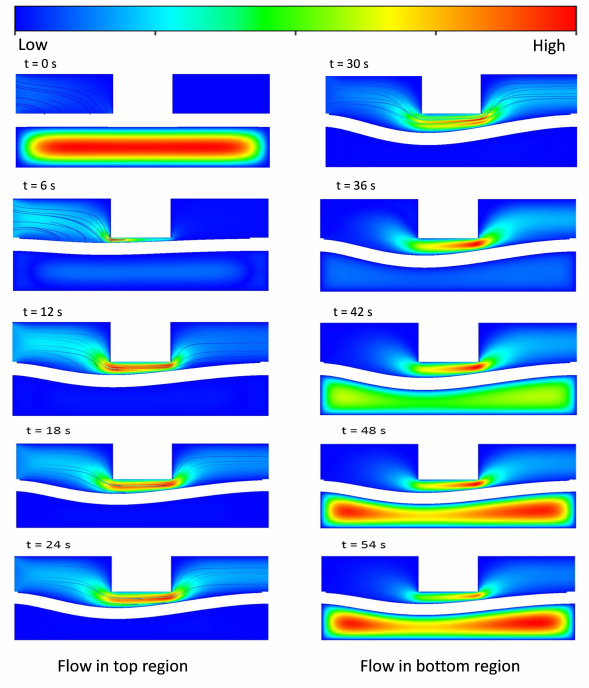
Figure 9. Velocity contours’ fields and streamlines for various time steps for L/W = 0 model in the A-A’ cross-sectional plane.